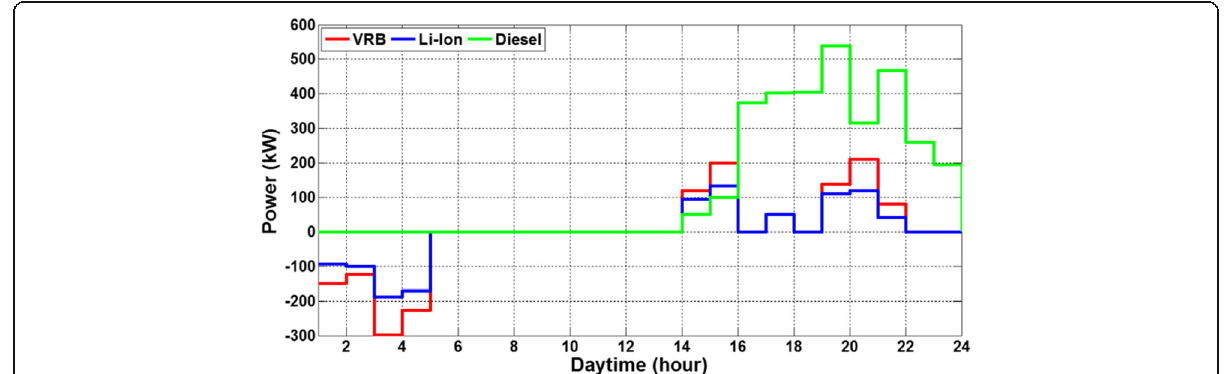
Fig. 8 Optimal dynamic scheduling using RegPSO in isolated mode